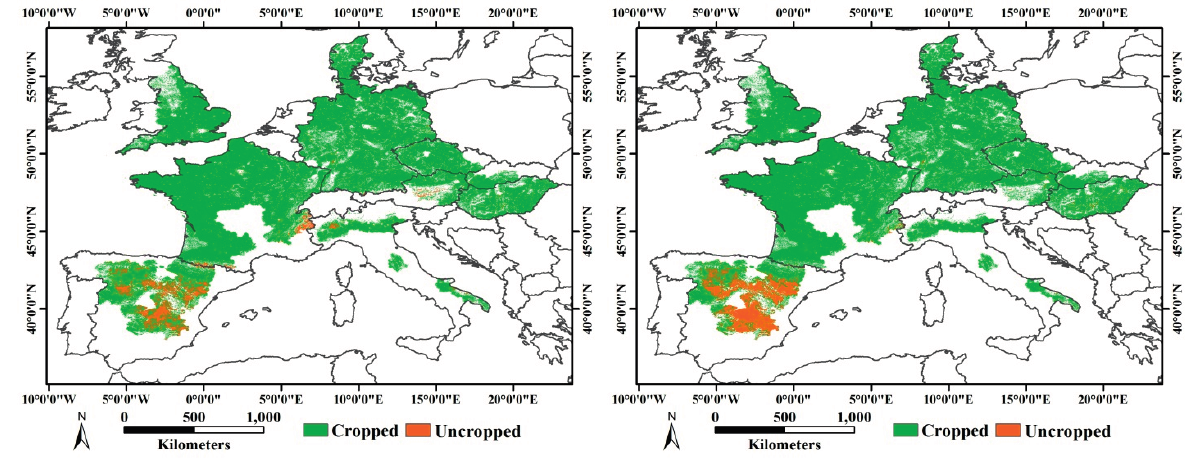
Figure 10. Cropped and uncropped arable land map for Western Europe over two time intervals. ( a ) January to April 2013; ( b ) October 2013 to January